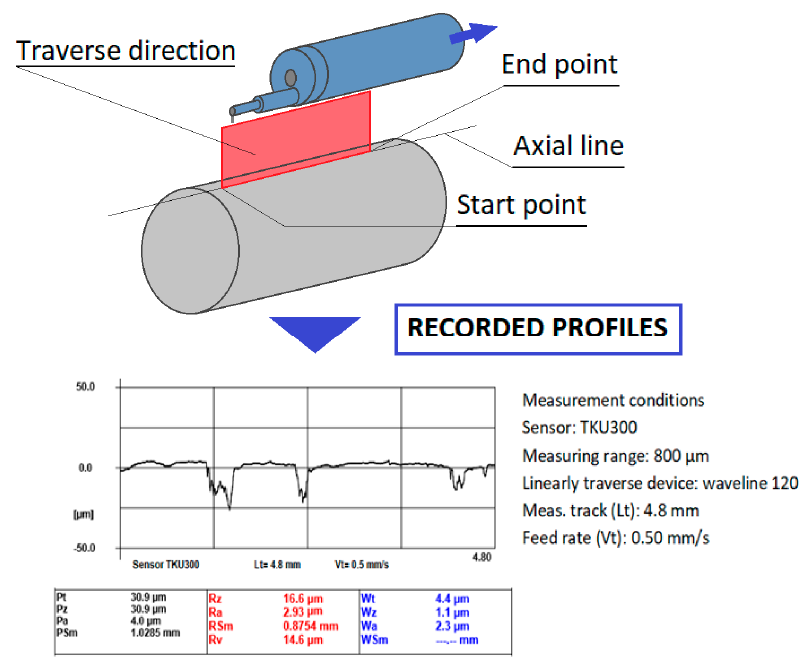
Figure 6. Measurement of surface roughness.